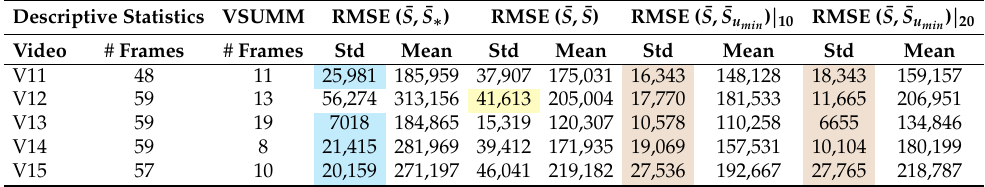
Table 5. VSUMM [1] comparison against baseline based on the Signature Transform for the first 20 videos of the dataset crawled from Youtube. Descriptive statistics with RMSE ( ¯ S , ¯ S summary against random uniform sample) and RMSE ( ¯ S , ¯ S ) (random uniform sample against random uniform sample). RMSE ( ¯ S , ¯ S u based on the Signature Transform using 10 and 20 random samples, respectively. Highlighted results are better than std (RMSE ( ¯ S , ¯ S ) ). Sampling rate: 1 frame per second. Highlighted results correspond to lowest standard deviation as described in Table